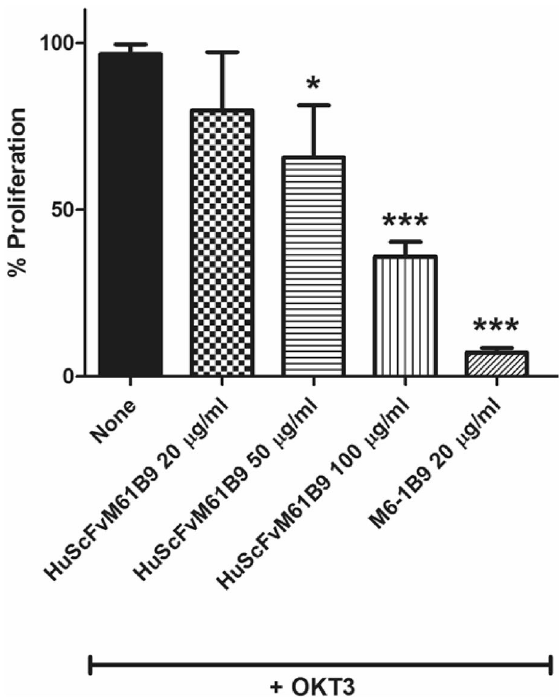
Figure 10. Inhibitory effects of HuScFvM61B9 on OKT3-induced T cell proliferation. PBMCs were stimulated with OKT3 in the presence of a various concentration of HuScFvM61B9. Cell proliferation was analyzed using flow cytometry by 5-carboxyfluorescein diacetate succinimidyl ester (CFSE) labeling. The data represented triplicate experiments and error bar (mean ± SD) performed by unpaired t-test (*p < 0.05, ***p <